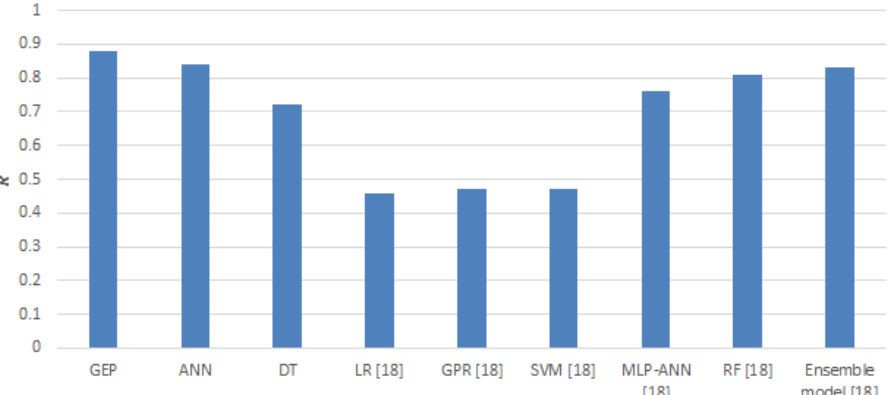
Figure 9. Comparison of the accuracy of different machine learning algorithms.